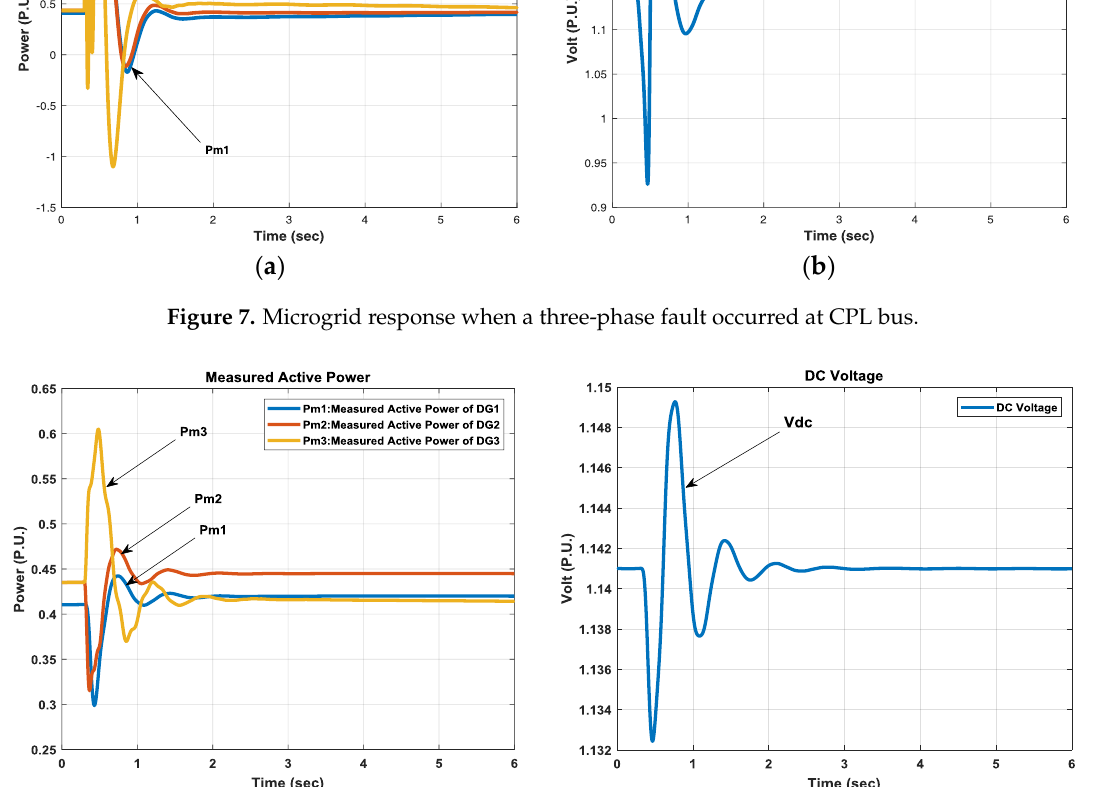
Figure 8. Microgrid response when a three-phase fault occurred at line 2.